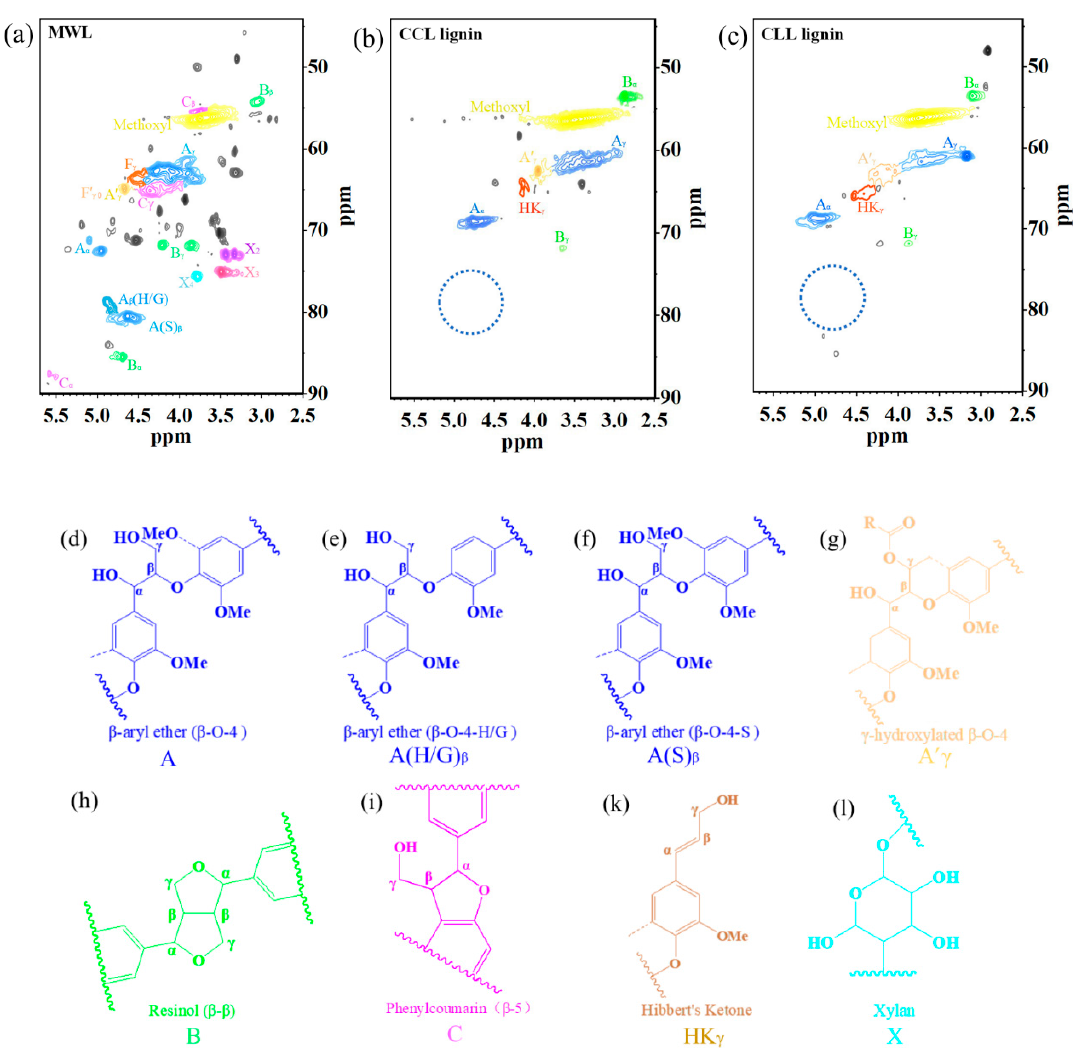
Figure 4. HSQC NMR analysis of MWL and DES lignin. ( a ) milled wood lignin; ( b ) lignin extracted by choline chloride-lactic acid; ( c ) lignin extracted by choline chloride-lactic acid; ( d ) β -O-4 aryl ether bond; ( e ) β -O-4-H / G aryl ether bond; ( f ) β -O-4-S aryl ether bond; ( g ) hydroxylated β -O-4; ( h ) resibol; ( i )Phenylcomarin; ( k ) Hibbert ′ s ketone; ( l ) xylan. The abbreviation of A, A(H/G) β , A(S) β , A ′γ , B, C,